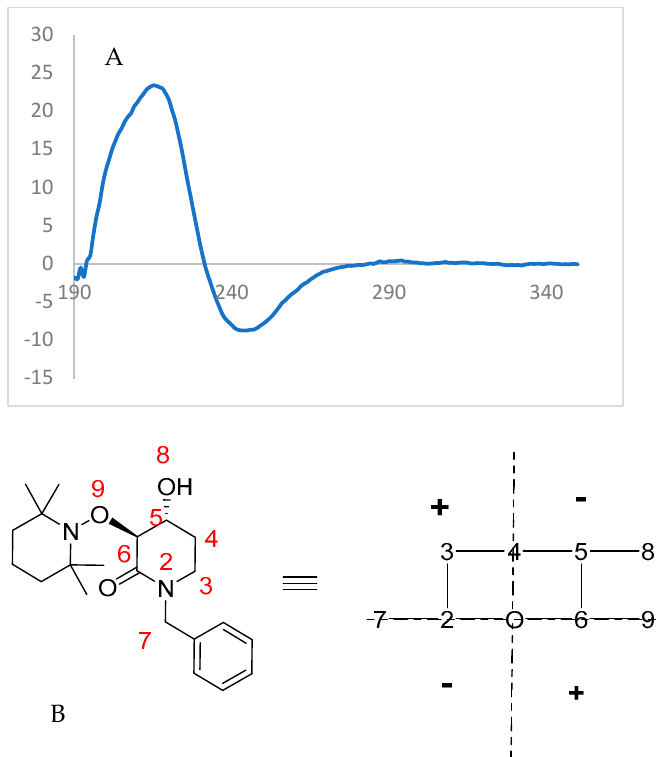
Figure 7. ( A ) Experimental CD spectrum of (3 S , 4 R )-(+)- 3 . ( B ) Structure transformed with octant rule; a negative cotton effect is expected.